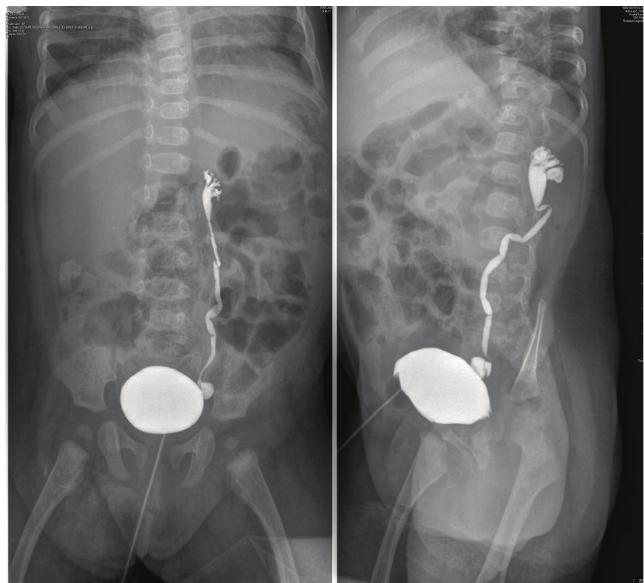
Figure 1: Voiding cystourethrogram showing unilateral reflux.